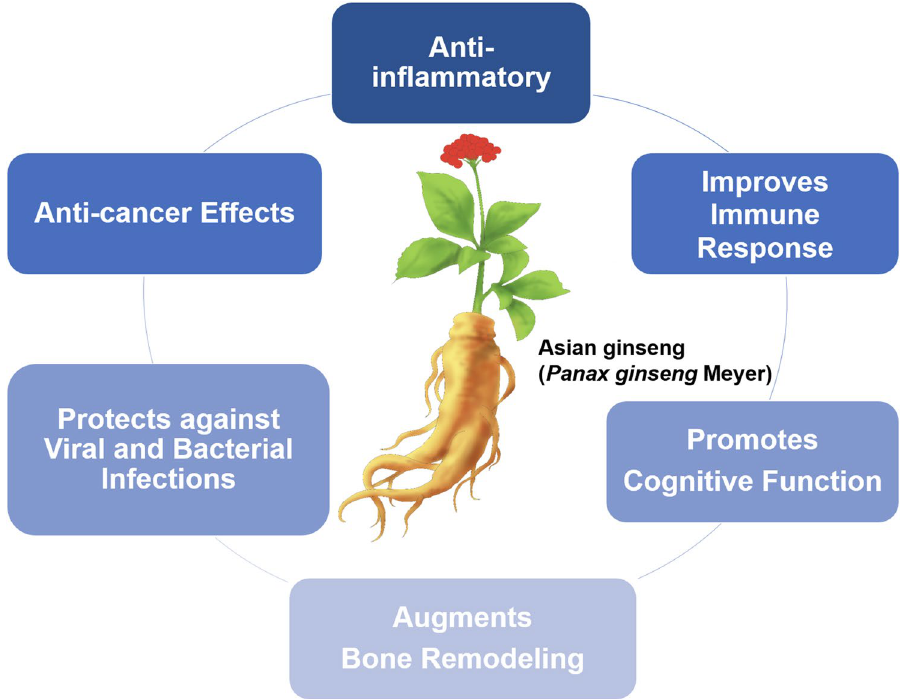
Fig. 1 Biological therapeutic activity of Panax